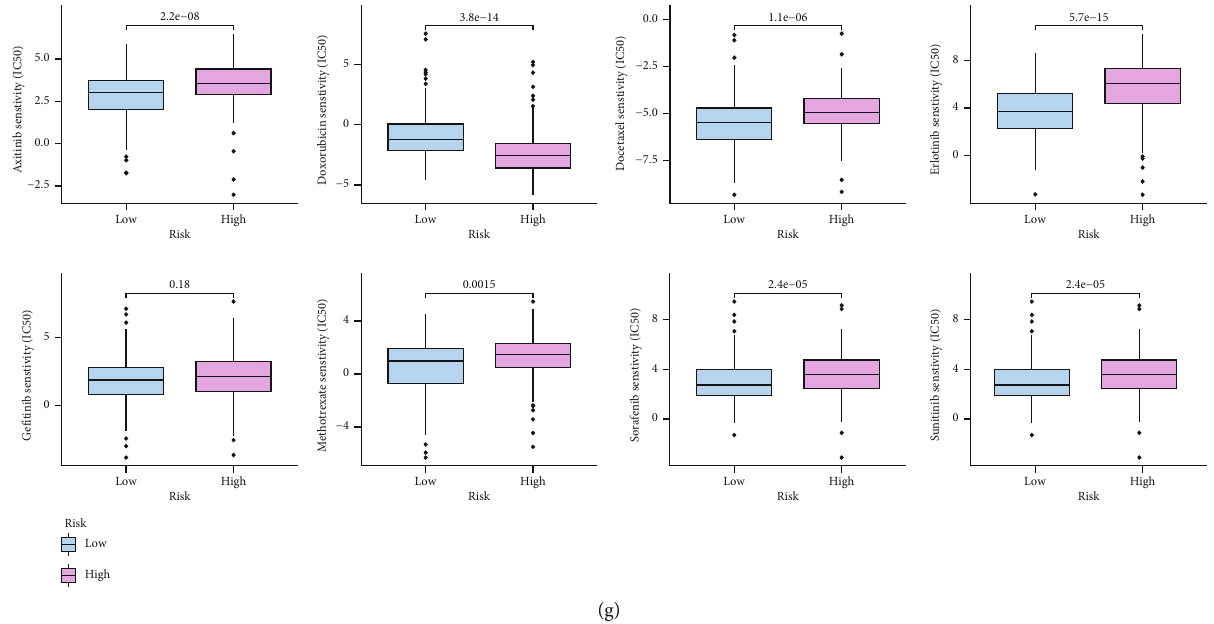
Figure 10: Validation of the role of BACE1-AS in hepatocellular carcinoma. (a) The combined e ff ect of BACE1-AS and NRP1 on the prognosis of hepatocellular carcinoma. (b) Analysis of survival status and gene expression in high- and low-risk patients. (c) Independent prognostic analysis of the 2-gene signature model risk score. (d) Prognosis di ff erence between high- and low-risk groups of HCC patients. (e) Area under the curve of the risk model at 1, 2, and 3 years. (f) Expression level of BACE1-AS in normal liver cells and liver cancer cells. (g) Evaluation of the e ff ect of risk model on drug